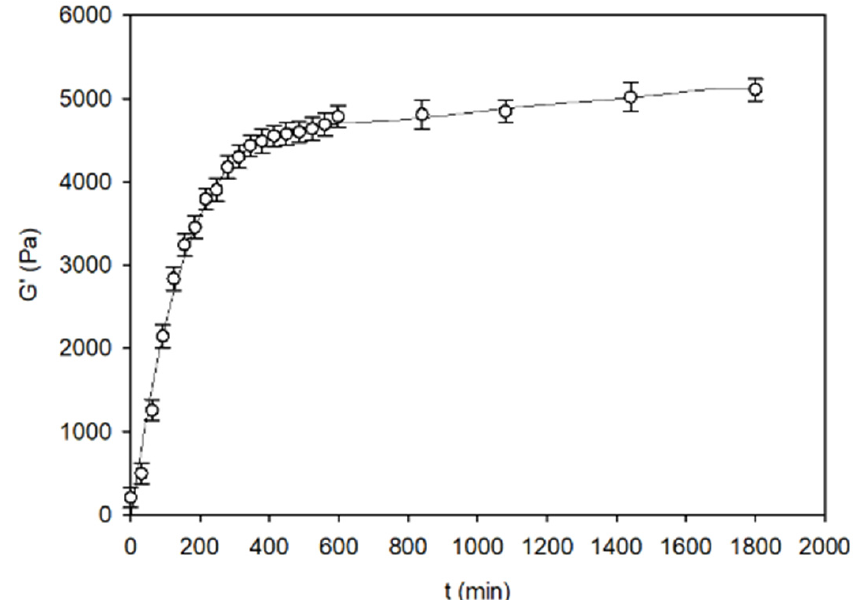
Figure 5. The kinetics of the storage modulus (G (cid:48) ) during the beef fat formation process. The values Figure 5 . The kinetics of the storage modulus (G’) during the beef fat formation process. The values